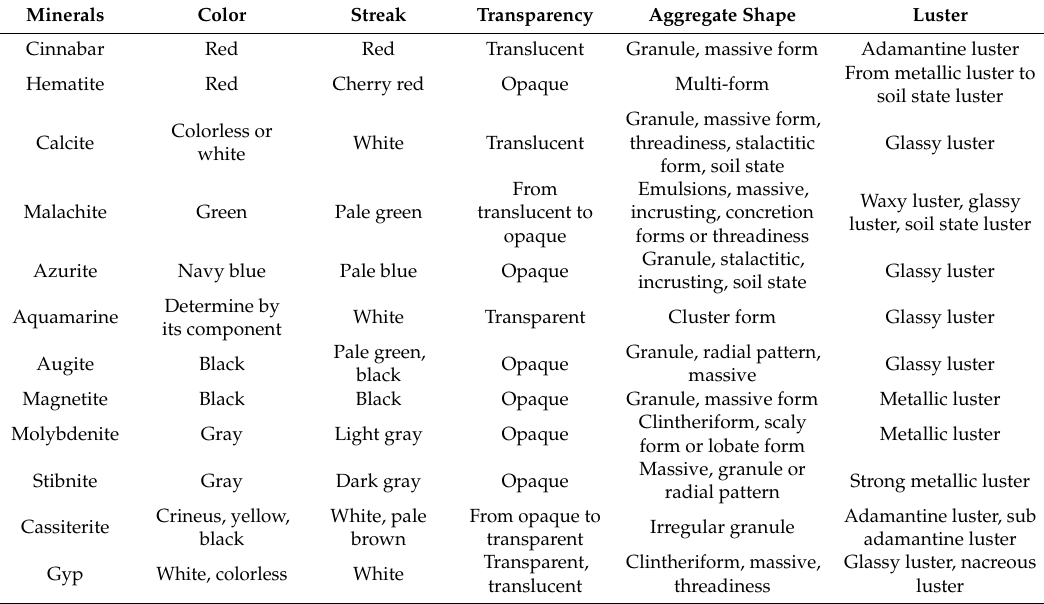
Table 1. Twelve kinds of rock mineral’s physical